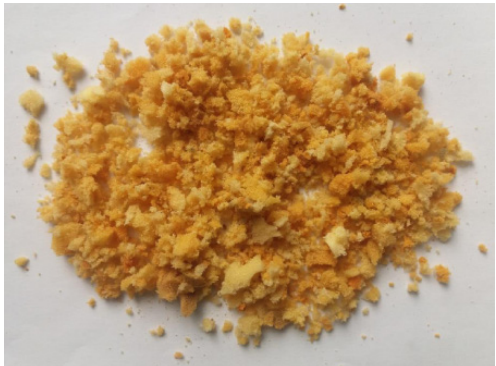
Figure 4. Ground fraction of PUR foam .